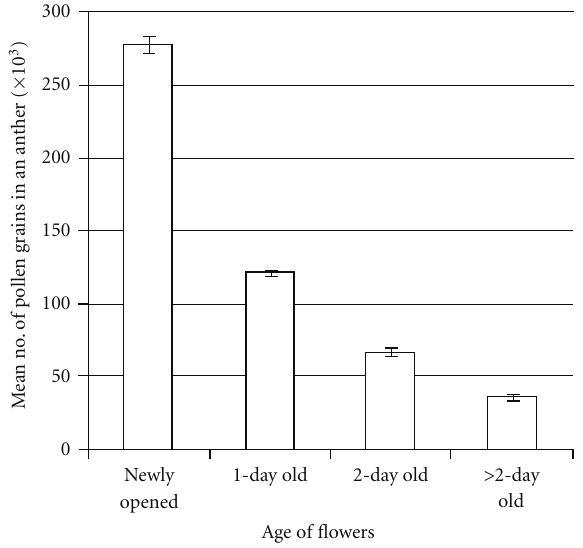
Figure 1: Variation in the mean number of pollen grains in an anther of Solanum violaceum as a function of the age of the